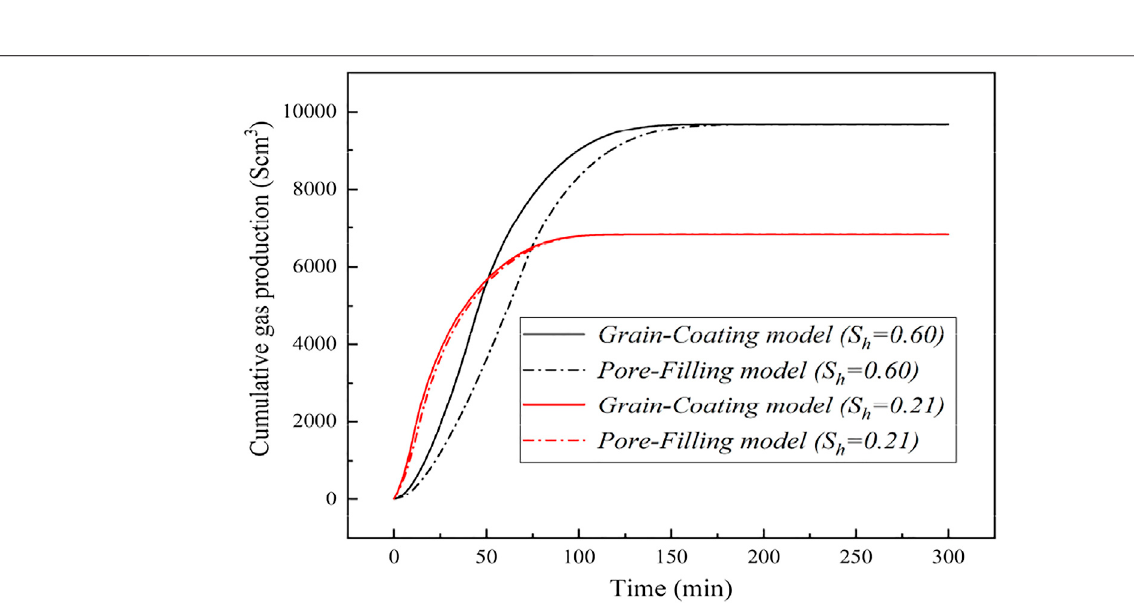
Frontiers in Energy Research |